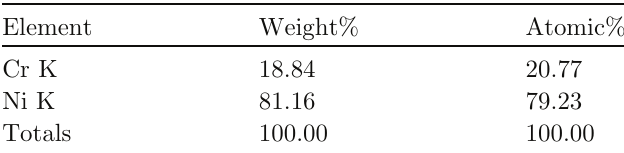
Table 1. Elements in nickel